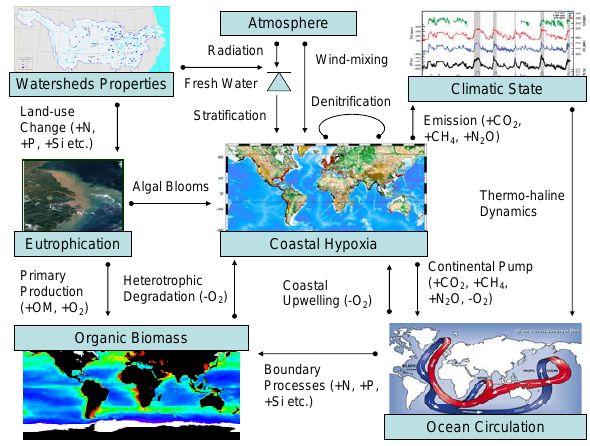
Figure 4. Fig. 4. Schematic view of hypoxia in the global coastal ocean, in which critical mechanisms and state of availability of nutrients, coastal hypoxia, marine primary productivity, and effect of climate change are highlighted. In the figure, the boxed variables are linked by a line terminated with a solid arrow head if the correlation is pos- itive or with a circle if the correlation is negative. If a path of con- nections can be traced back to itself, a feedback loop is formed with circle ends (e.g. denitrication involves complex mechanisms that interact with hypoxia with strong feedbacks to the nitrogen cycle). The amplification and/or regulation of driving forces are displayed with a sign of audio symbol. Usually, stratification in coastal envi- ronments is caused, and subsequently maintained, by surface-layer warming and freshwater input from rivers (e.g. buoyancy effect), or excess rainfall (e.g. the monsoon season), a combination that has a more significant effect than any single factor. Changes in land-use, application of chemical fertilizers in agriculture and hydrographic engineering (e.g. damming) can induce variations in freshwaters and nutrients influx to the adjacent marine waters. An increase in deposition flux of organic matter, either labile (e.g. plankton detri- tus from in situ production) or refractory (e.g. soil organic materials from watersheds), or both can stimulate heterotrophic metabolisms (e.g. respiration) and chemoautotrophy (e.g. oxidation of ammo- nium) in the deeper part of the water column and bottom sediments, using oxygen as electron acceptor. Climate state affects the vari- ability of ocean circulation, and hence the development of coastal hypoxia through boundary circulation shelf/coast interactions. All these dynamic processes affect the inventory of dissolved oxygen in the coastal environment, and hence the fate of hypoxia; the combi- nation of different processes often has a more profound impact than any single factor on the persistence of coastal hypoxia. In terms of feedbacks to the Earth System, coastal hypoxia is a source of trace gas species (e.g. CH 4 and N 2 O) to the atmosphere and open ocean, and in extreme cases like in the Gulf of Mexico, CH4 concentra- tions in surface waters are up to 1000 times saturation with respect to atmospheric equilibrium (Solomon et al., 2009), due to the es- cape of hydrate bubbles from marine seeps. The sub-figures are from JGOFS/IGBP (Web-site: http://www1.whoi.edu/index.html), NASA (Web-site: http://science.nasa.gov/headlines/y2004/05mar